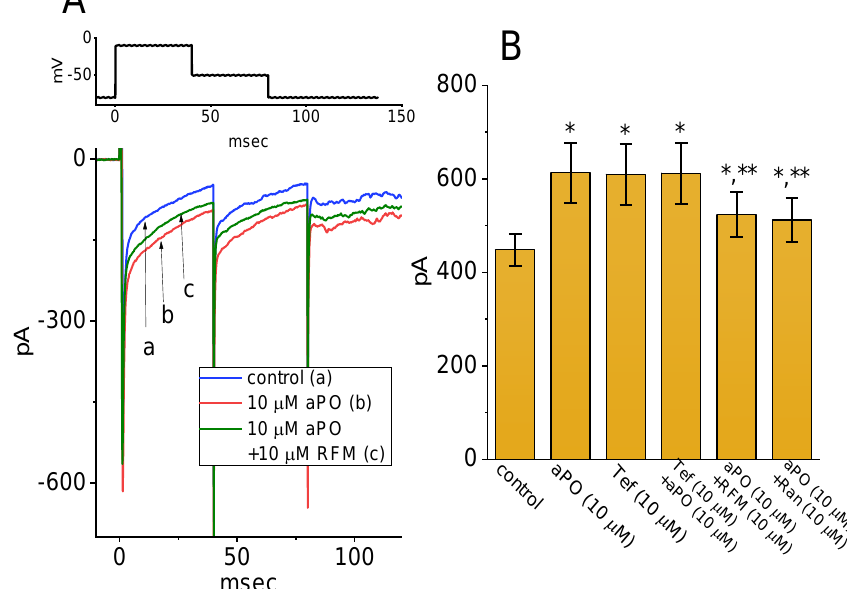
Figure 4. Effect of aPO , tefluthrin (Tef), Tef plus aPO , aPO plus rufinamide (RFM), and aPO plus ranolazine (Ran) on peak amplitude of I Na identified in GH 3 cells. ( A ) Representative I Na traces activated by depolarizing pulse (as indicated in the upper part). a: control; b: 10 µ M aPO ; c: 10 µ M aPO plus 10 µ M RFM. ( B ) Summary bar graph showing effect of aPO , Tef, Tef plus aPO , aPO plus RFM, and aPO plus Ran on peak I Na (mean ± SEM; n = 8–10 for each bar). The number of the control group is 10, while those in other groups are 8. Data analysis was performed by ANOVA-1 ( p < 0.05). * Significantly different from control ( p < 0.05) and ** significantly different from aPO (10 µ M) alone group ( p < 0.05).